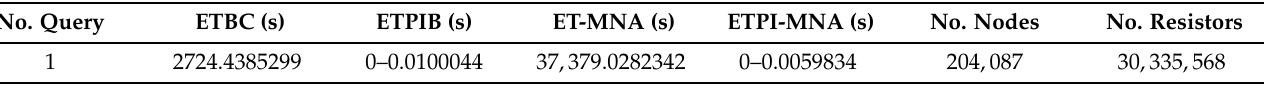
Table 9. Execution time of case study 3 (KUKA six-DOF manipulator). ETBC: execution time of bitmap creation, ETPIB: execution time per iteration in the bitmap creation process, ET-MNA: execution time of MNA creation, ETPI-MNA: execution time per iteration in the MNA creation